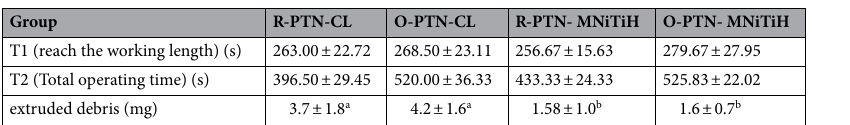
Table 3. Weight of Apically Extruded Debris in Milligrams (mean ± standard deviation) and Time Used for Instrumentation in seconds. Different superscript letters indicate statistical difference ( P < 0.05).